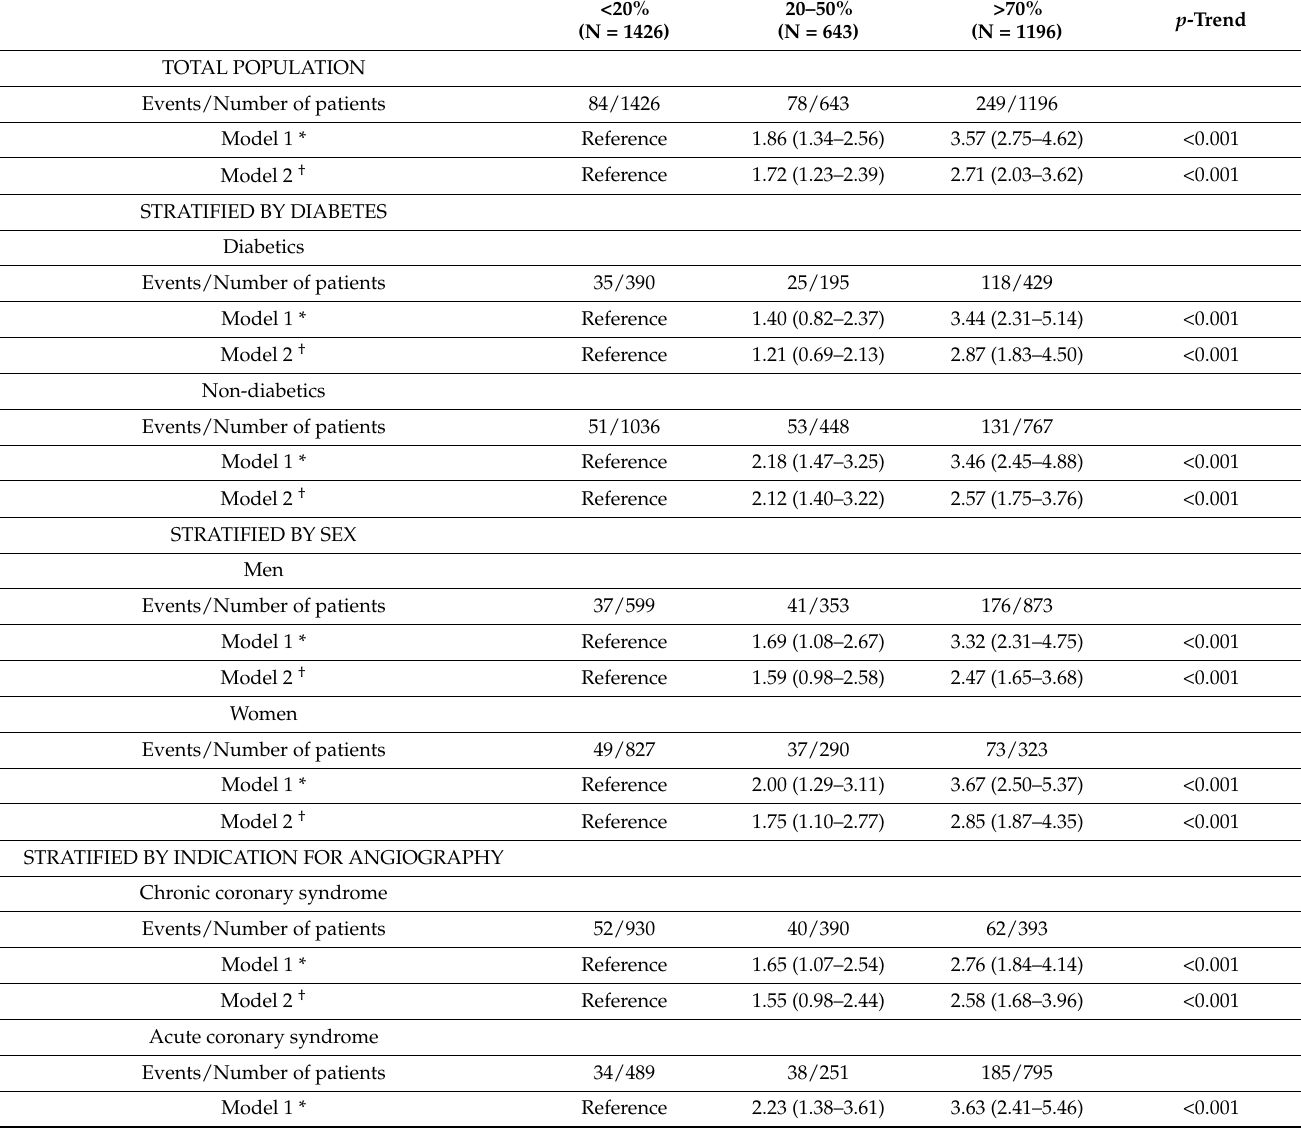
Table 3. Hazard ratios of cardiovascular event according to the degree of coronary artery